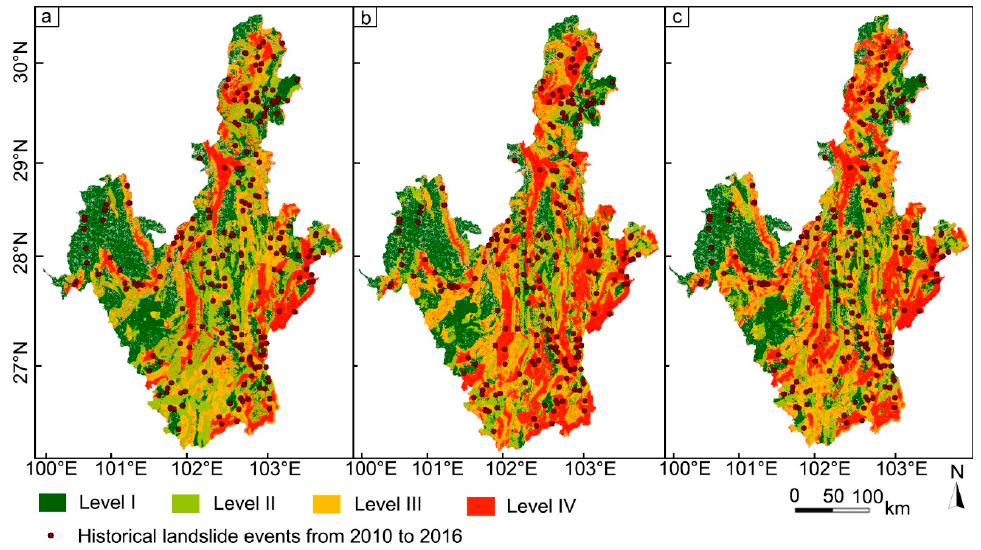
Figure 7. Topography changes revealed by the DEM data: ( a ) from 1992 to 2000; ( b ) from 2000 to 2009.